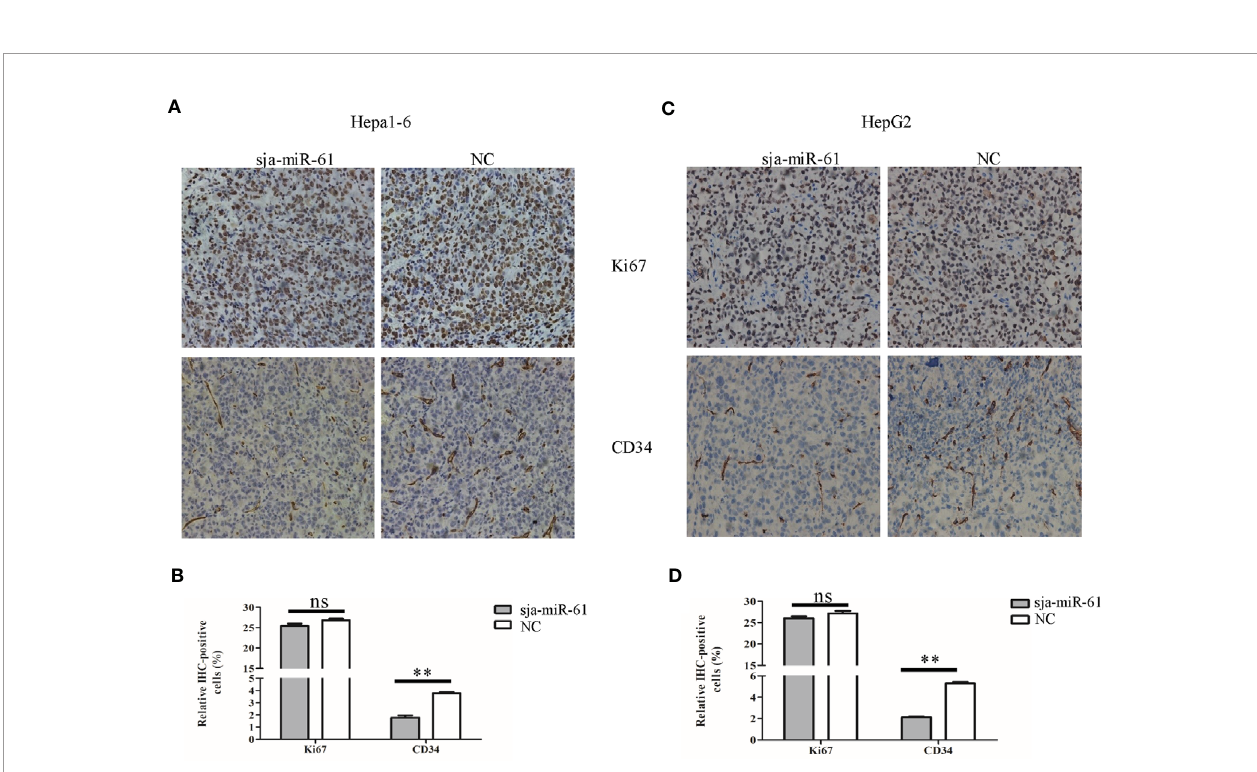
FIGURE 6 | Detection of the expression of both Ki67 and CD34 in tumors. (A – D) The expression levels of both Ki67 and CD34 in tumors were determined using immunohistochemistry, (A, B) for Hepa1-6 cells, (C, D) for HepG2 cells. Data are presented as the mean ± SD, n = 6, ** p < 0.01, ns indicates no signi fi cant.